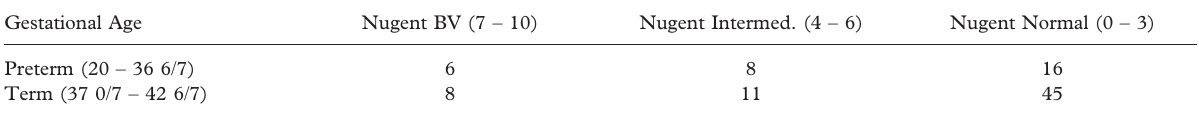
Table I. Admission Nugent Scores correlated with Gestational Age at